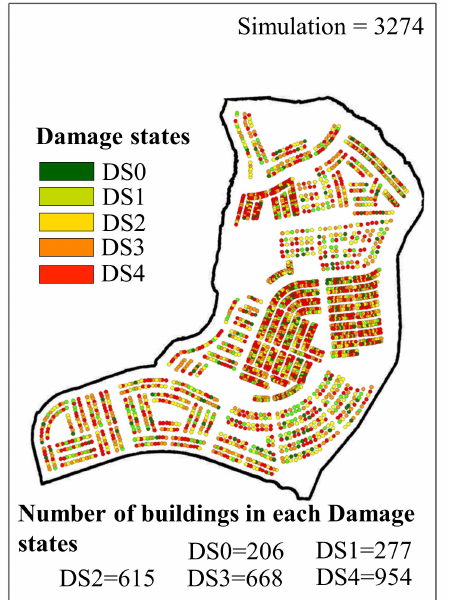
Figure 8. Damage states of community building portfolio under a given